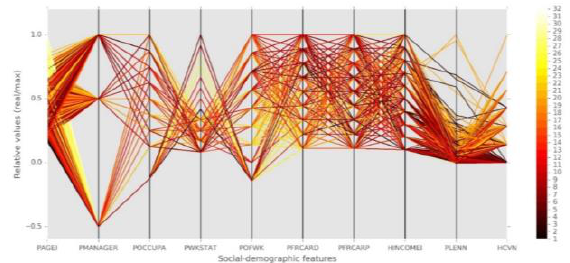
Figure 6. Sankey plot of 32 social-demographic groups